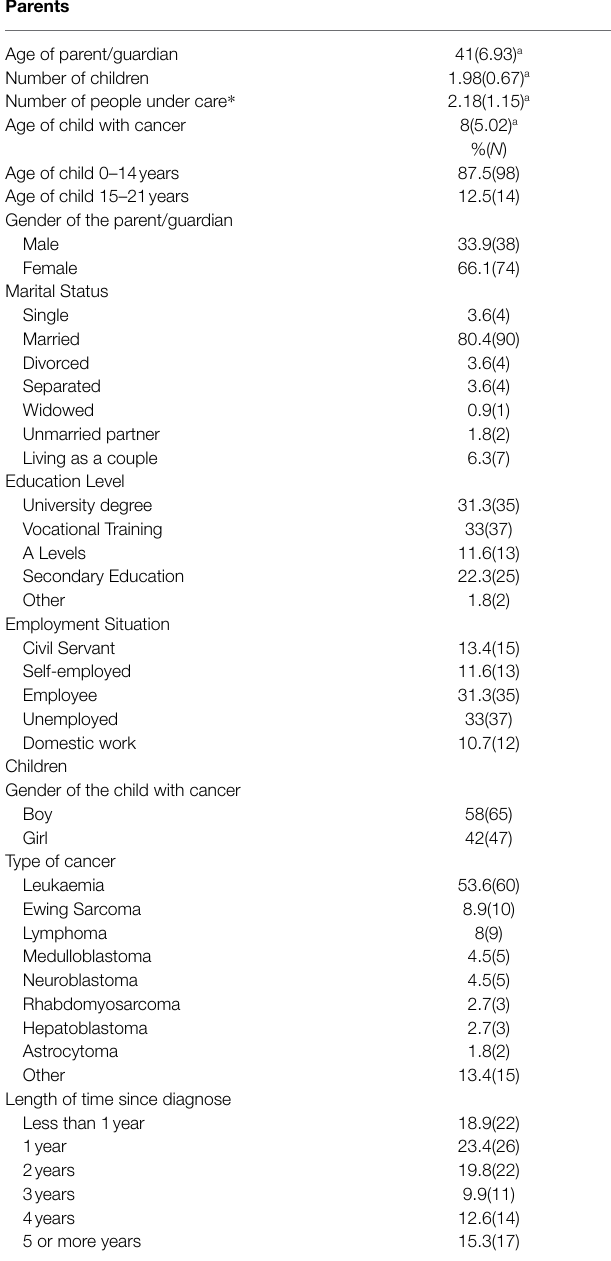
TABLE 1 | Sociodemographic variables ( n =